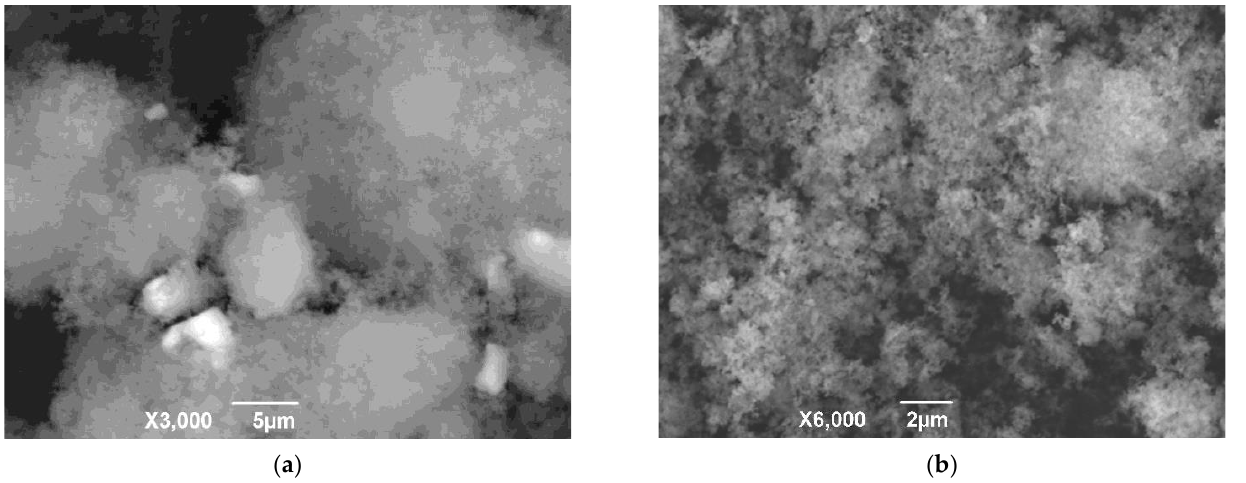
Figure 16. SEM images of white carbon without ( a ) and after water washing ( b ).